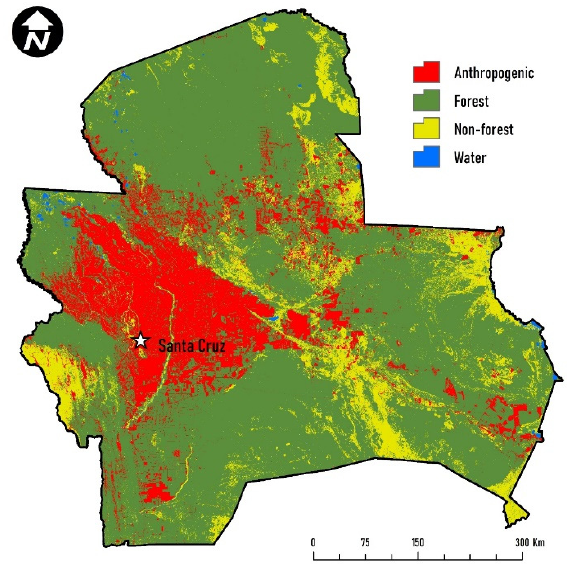
Figure 3. Anthropogenic land use and vegetation cover of the Department of Santa Cruz.